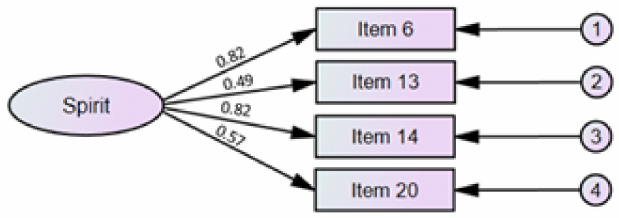
Figure 2. Structure of the short version of the Interfaith Spirituality